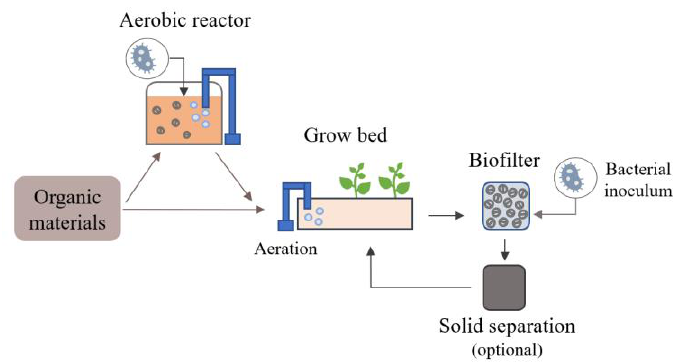
Figure 2. Schematic of organic materials aerobic degradation integrated and/or external to the bioponic system.